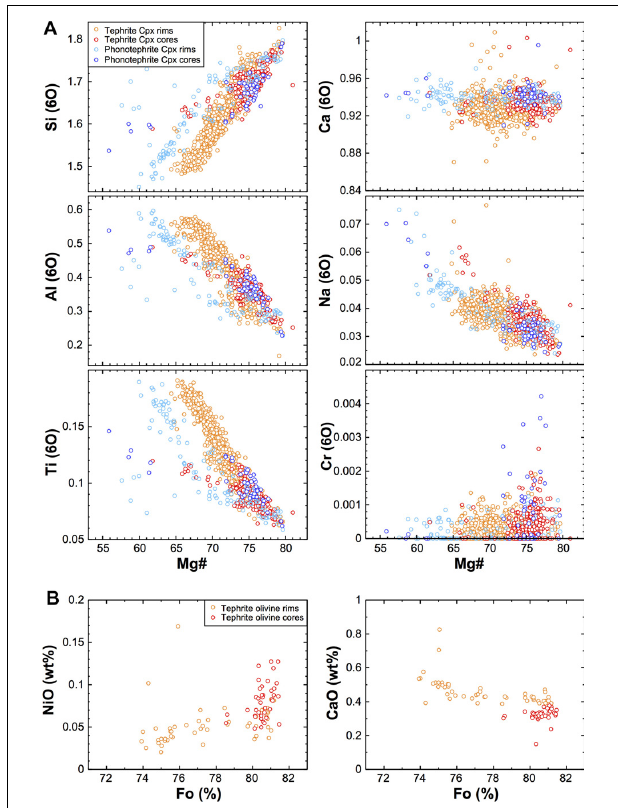
FIGURE 4 | (A) Compositional variations of clinopyroxene phenocrysts in tephrites and phonotephrites, plotted as Mg# versus cation fractions normalized to six oxygens. Rim compositions were analyzed at 3–8 µ m distance to planar crystal faces, all other analyses are denoted as cores. Note the different trends of phonotephrite- and tephrite-hosted clinopyroxene rims in the diagrams of Mg# versus Si, Ti and Al. (B) Compositional variations of olivine phenocrysts in tephrites. Note the small range of rim compositions (Fo 74 - 81 ) as compared to clinopyroxene rims (Mg# of 64–79).